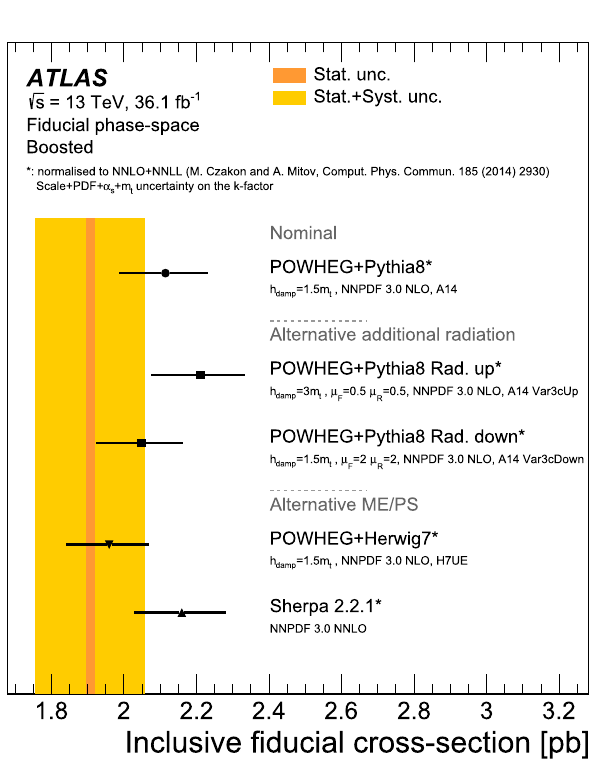
Fig. 53 Comparison of the measured inclusive fiducial cross-section in the boosted topology with the predictions from several MC genera- tors. The bands represent the statistical and total uncertainty in the data.